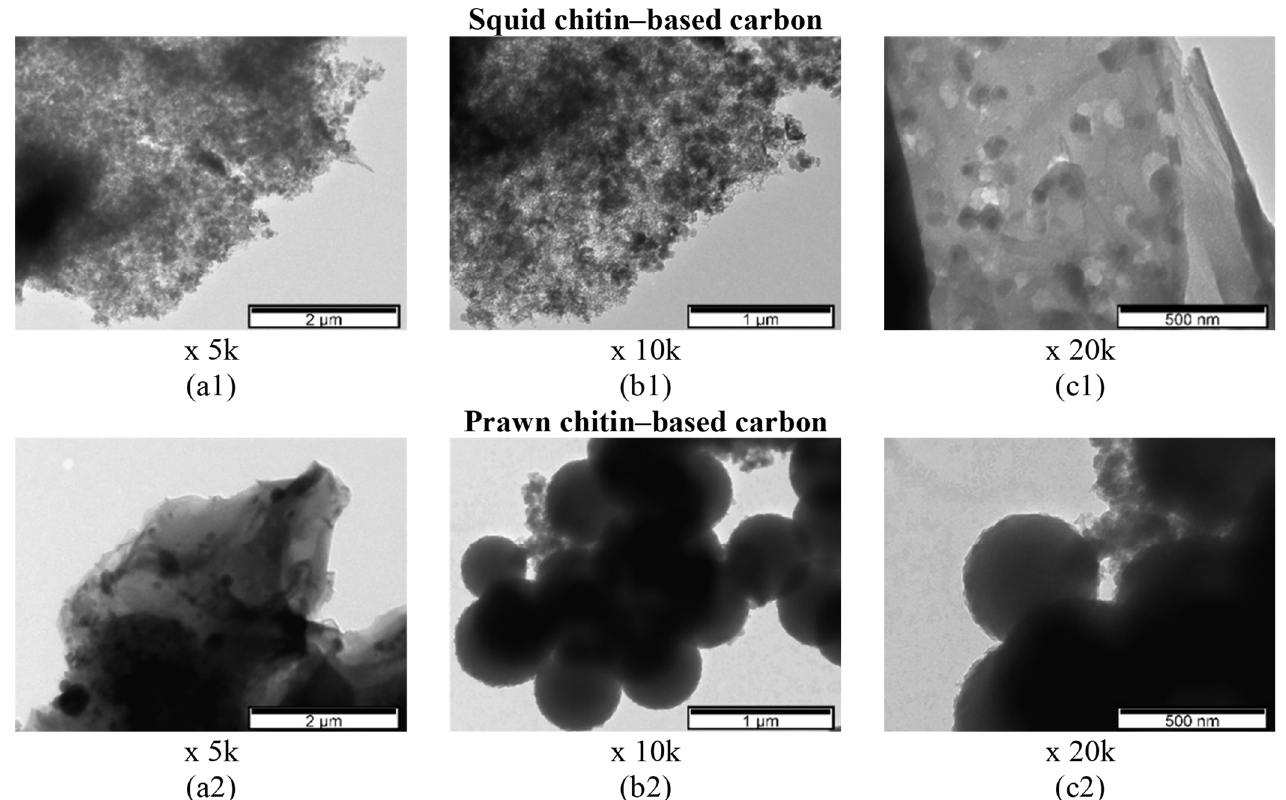
Figure 4. TEM images of squid and prawn chitin-based carbons (carbonized at 1000 °C for 1 h) at different magnifications: ×5 k ( a1 , a2 ), ×10 k ( b1 , b2 ), and ×20 k ( c1 , c2 ).